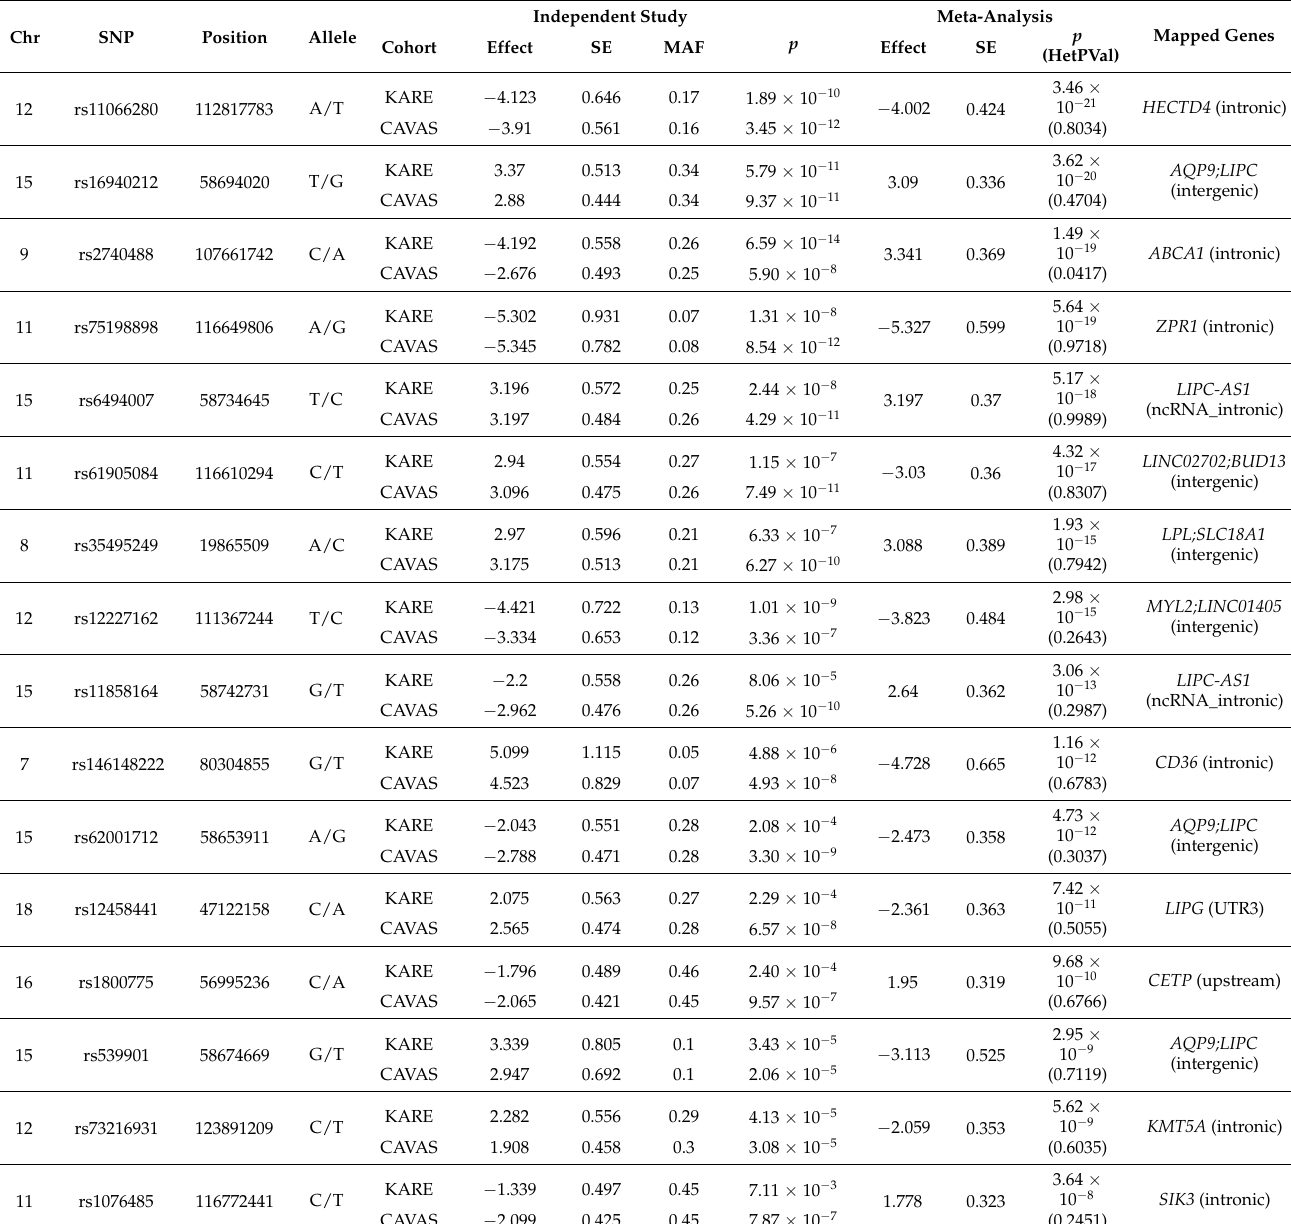
Table 2. Results of GWAS meta-analysis of ApoA1 (leading